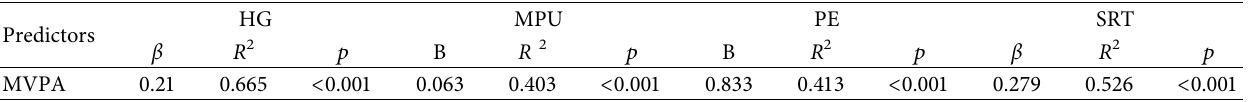
Table 5: Linear regression model relationship between physical fitness and MVPA (girls, n � 1477).